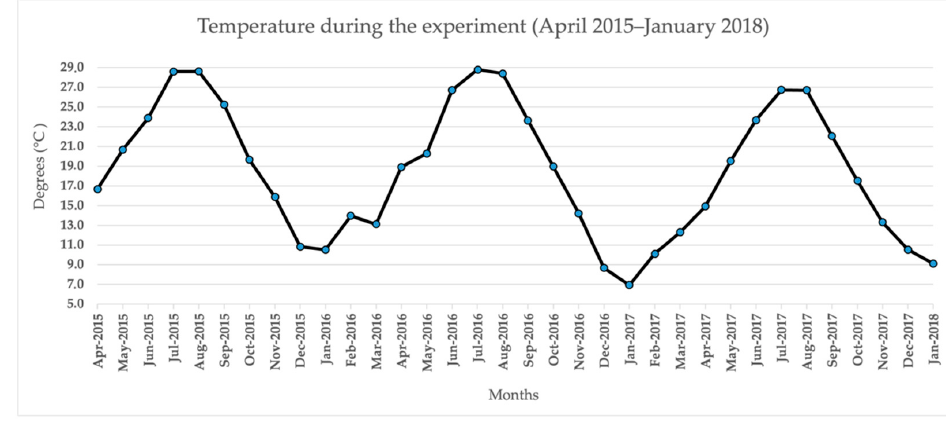
Figure 1. Climatic parameter of temperature during the experiment (April 2015 to January 2018). As to the phenolic content in ‘Prime©’ and ‘Ralli’ in relation to (i) each studied variety; and (ii) the lapse of days between applications and cane sampling, it is presented in Table 2. Table 2. Variation of individual phenolic content in relation to the variety under study and the lapse of days between applications and cane sampling.